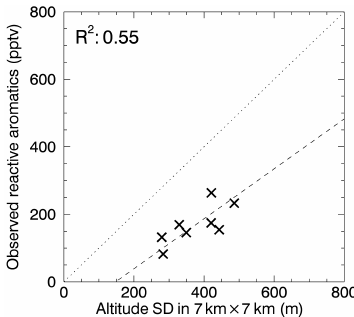
Figure 8. Observed reactive aromatics as a function of terrain com- plex during period 3. The latter is computed as the standard devi- ation of altitude in a 7km × 7km region centered at the sampling location. The dash line denotes a least-squares